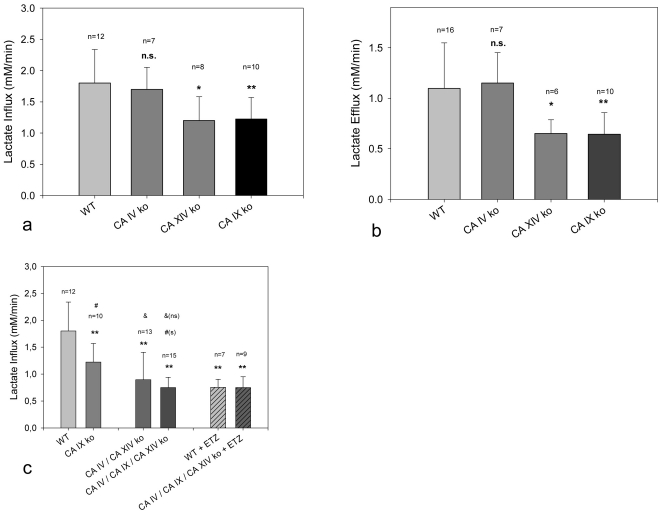
Lactate influx and efflux measurements in EDL fibers from various knockout mice.a) Lactate influxes in WT, CA IV ko, CA XIV ko and CA IX ko fibers. b) Lactate effluxes from the same combination of fibers as in 4a. c) Comparisons of lactate influxes in WT vs. CA IX ko fibers (left), in CA IV-CA XIV double ko vs. CA IV-CA IX-CA XIV triple ko (middle), and WT vs. triple ko, both in the presence of the membrane-permeable CA inhibitor ethoxzolamide (right). Columns for lactate influxes in WT, CA IV ko, CA XIV ko, and CA IV/CA XIV double ko are the same as in Fig. 3. Stars indicate significant differences from WT (* P<0.05; ** P<0.01). #(s) indicates a significant difference between the CA IX ko and the triple ko fluxes (P<0.05), &(ns) indicates that there is no significant difference between double ko and triple ko fluxes.